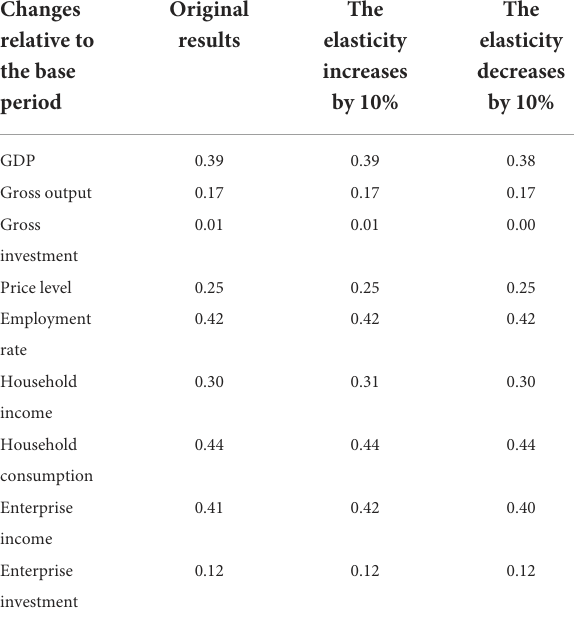
TABLE 3 Robustness test for exempting VAT for designated sectors (Unit: